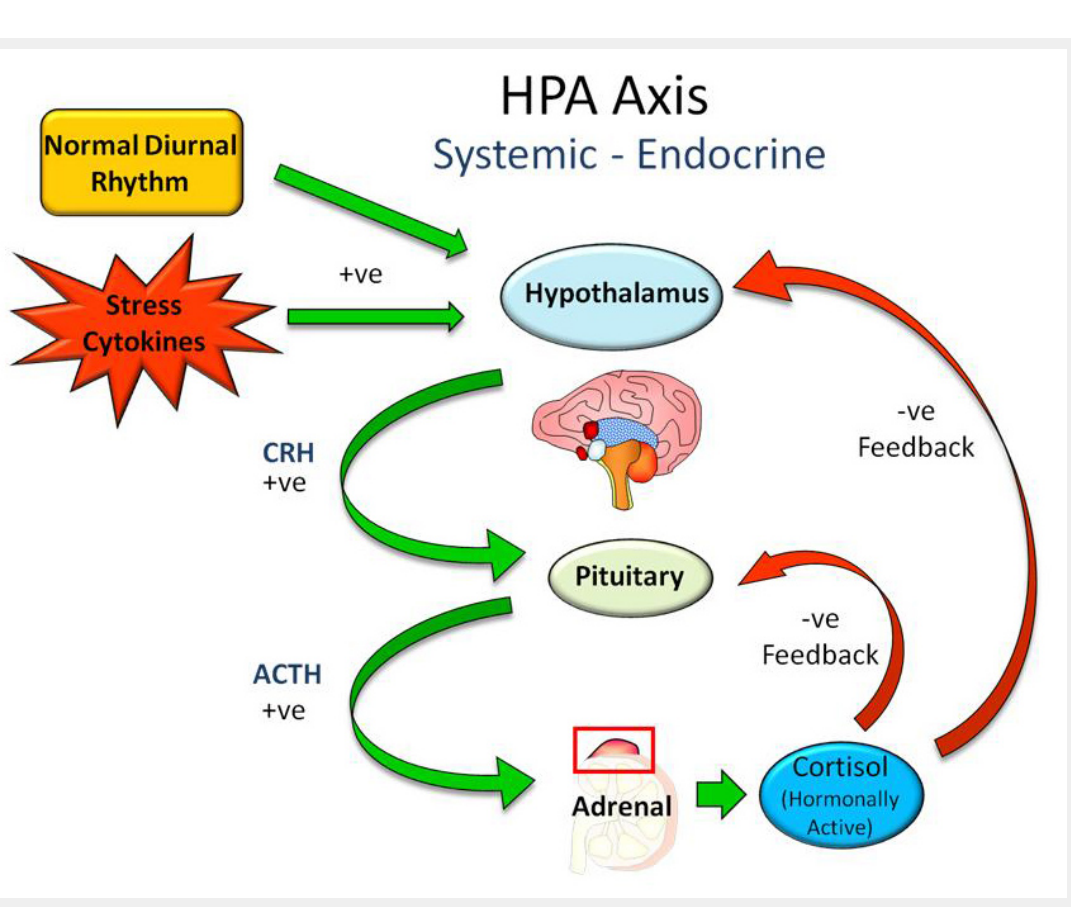
Figure 1 Systemic regulation of circulating cortisol levels by the hypothalamic pituitary adrenal (HPA) axis. Signalling to the hypothalamus by the normal circadian rhythm, stress, and pro-inflammatory cytokines increase release of corticotropin releasing hormone (CRH) from the hypothalamus. This acts on the pituitary to increase release of adrenocorticotropic hormone (ACTH) that acts to increase cortisol synthesis and secretion from the adrenal gland. Cortisol suppresses both CRF and ACTH at the pituitary and hypothalamus and a negative feedback